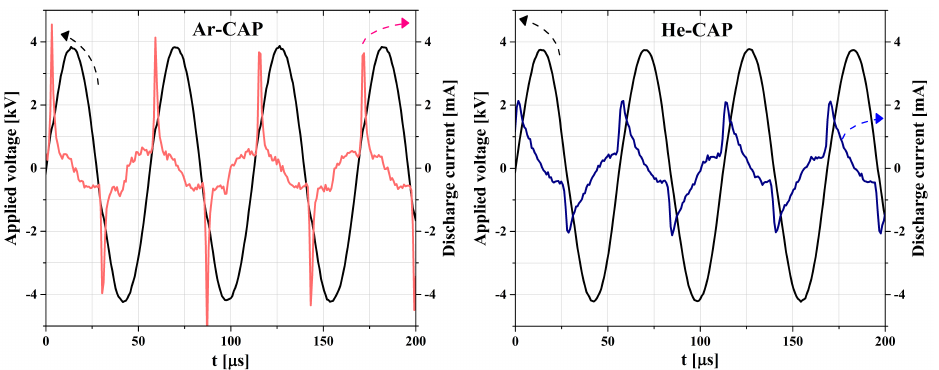
Figure 2. The applied voltage and discharge current for the Ar ( left ) and He ( right ) CAP in mid air (no